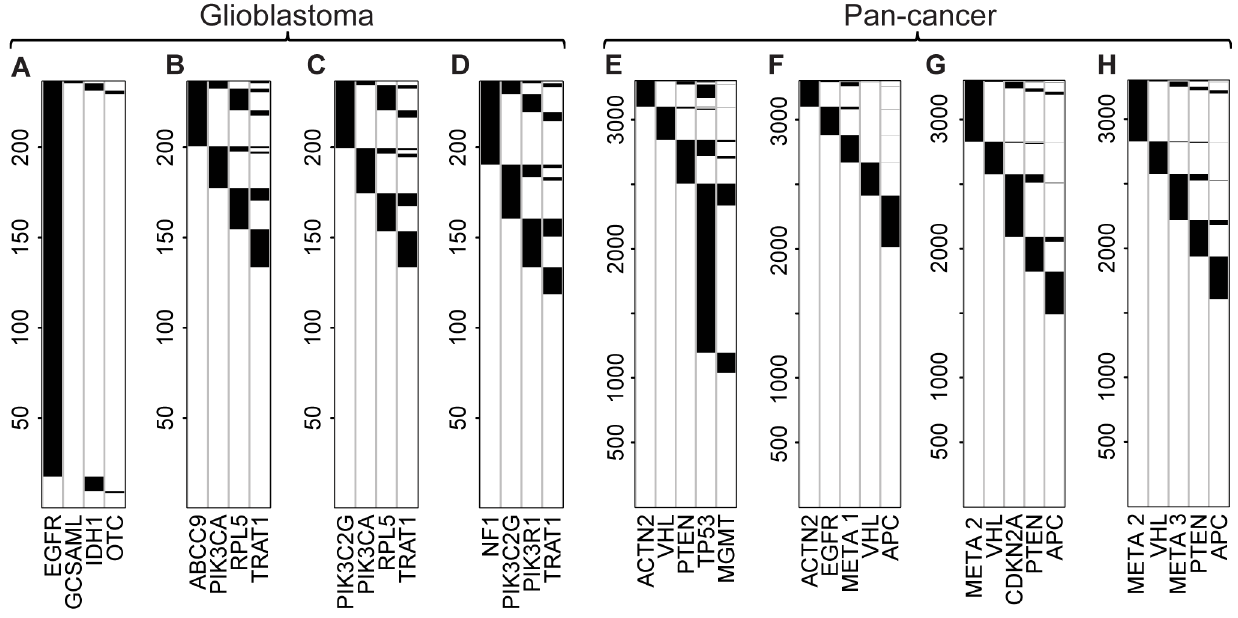
Figure 3. Top mutual exclusivity patterns identified in cancer data. A–D Patterns in glioblastoma. A Pattern for the gene set with the highest weight (scoring high coverage and low impurity, applied in previous studies), with adjusted permutation test p-value 0. B–D Examples of significant, high quality patterns identified using the reduced mutual exclusivity model (assuming no errors), with estimated coverage larger by 0.3 and impurity lower than 0.2. E–H Patterns in pan-cancer data. E Pattern the for gene set with the highest weight. F–H Examples of significant, high quality patterns identified using the mutual exclusivity model that accounts for false positives, with estimated coverage larger by 0.3 and impurity lower than 0.2.